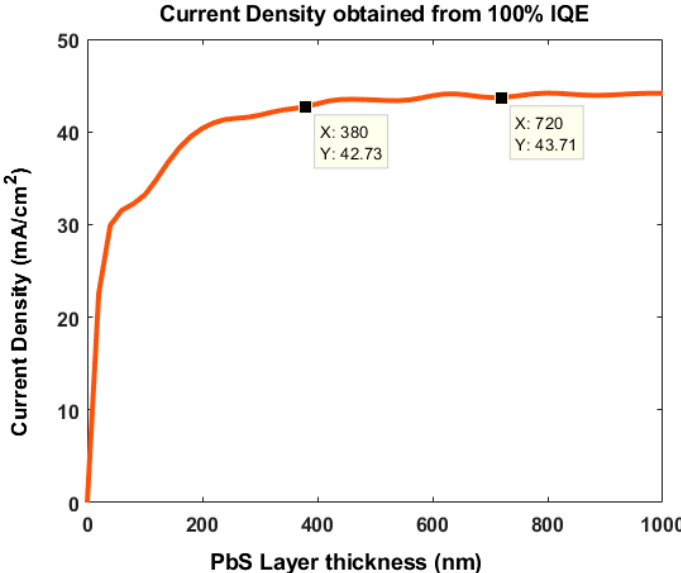
Figure 1. ( a ) Schematic diagram and ( b ) energy level diagram of the PbS quantum dot (QD) photovoltaic device used in this study.